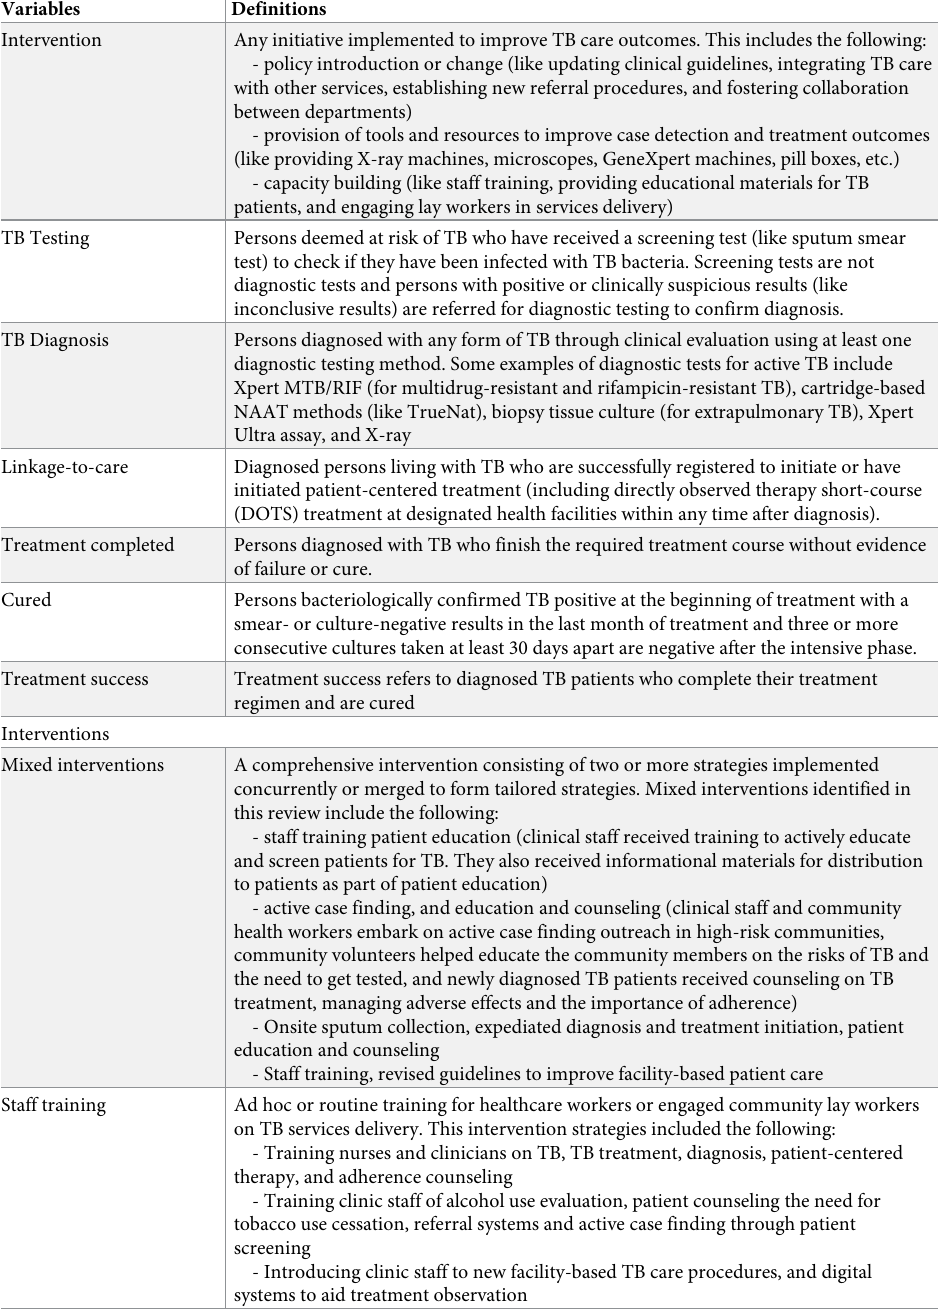
Table 2. Definitions of care cascade outcomes, interventions, and strategies discussed in this